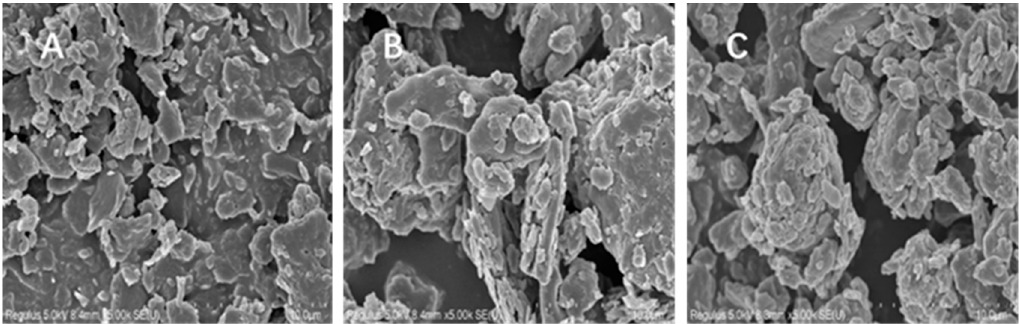
Figure 1. Scanning electron micrographs of GTP 1 ( A ), GTP 2 ( B ) and GTP 3 ( C ).